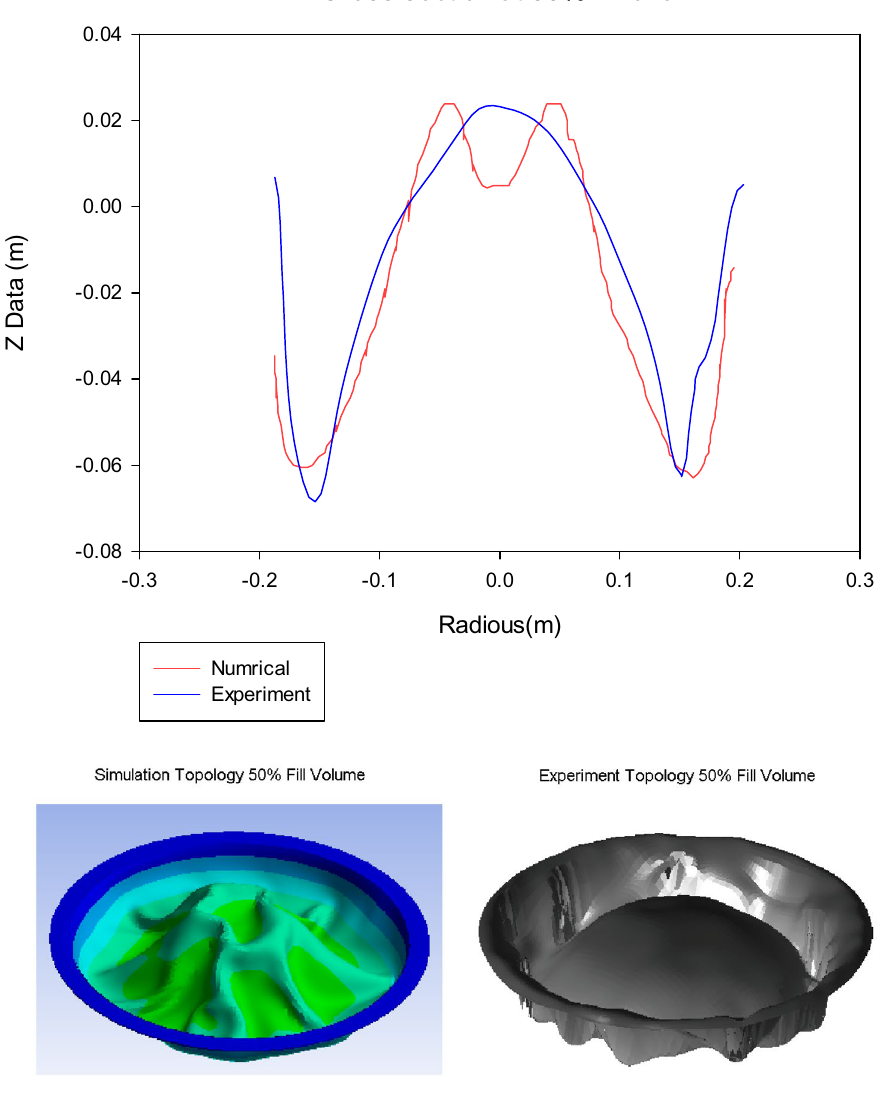
Fig. 19 Comparison between numerical simulation results and experimental scans of diaphragm at 50% fill